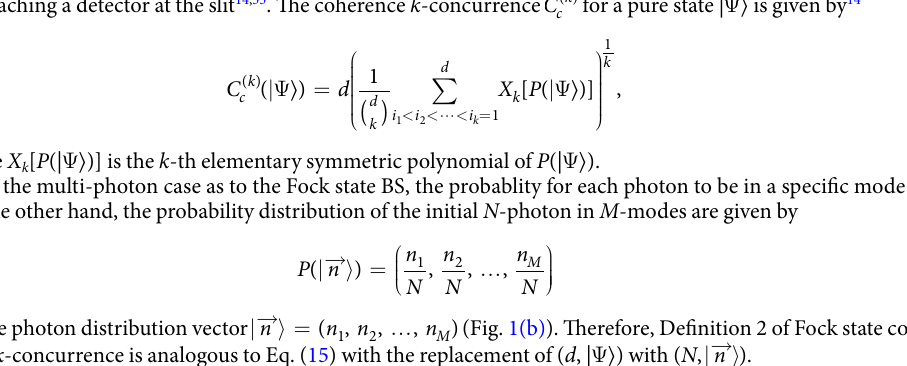
(Fig. 1(b)). Therefore, Definition 2 of Fock state coher-